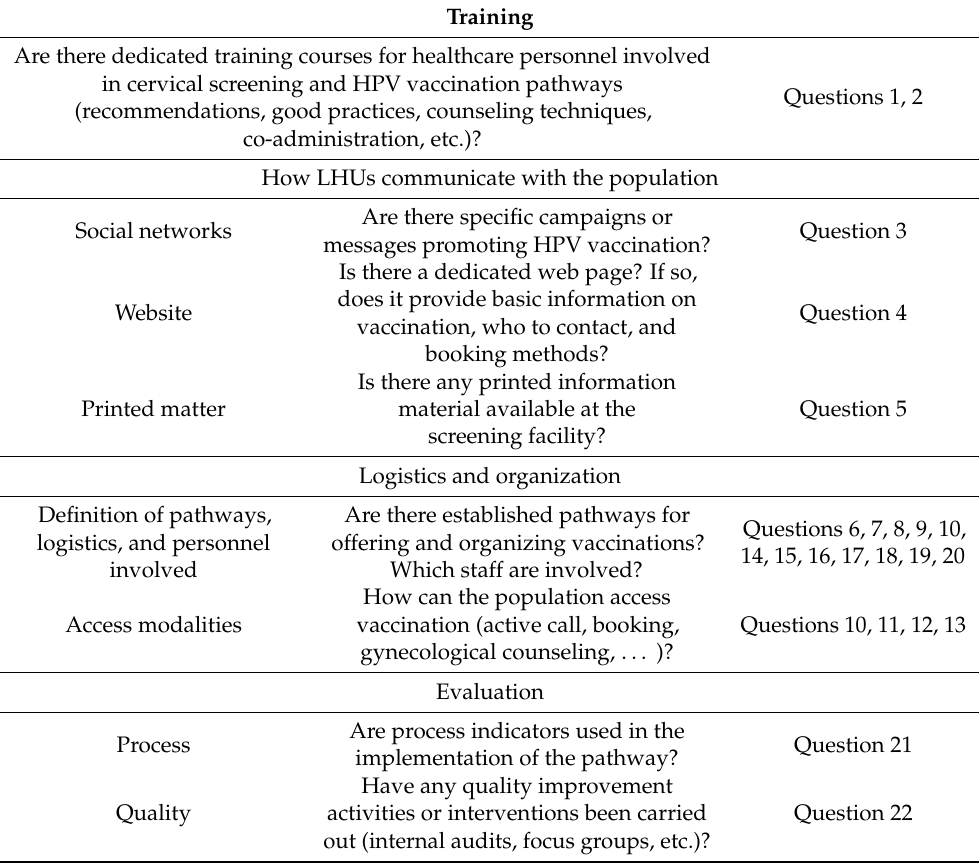
Table 1. Pathway for offering HPV vaccination to women with CIN2+ lesions, developed in the light of focus groups held with experts working at Cervical Screening and Vaccinations